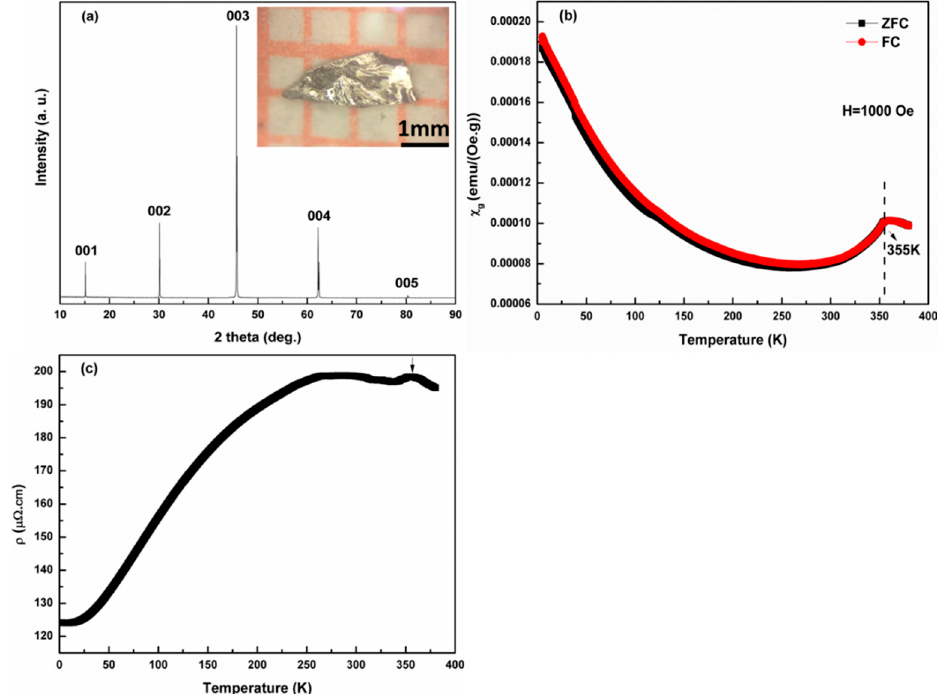
Figure 1. ( a ) X-ray diffraction (XRD) pattern of Fe 2 As single crystal. The inset shows the photograph of Fe 2 As single crystal; ( b ) Zero-field cooled (ZFC) and field cooled (FC) susceptibilities versus temperature for Fe 2 As single crystal with applied magnetic field parallel to ab-plane, an obvious antiferromagnetic transition can be seen at about 355 K; ( c ) Temperature dependence of ab plane resistance at ambient pressure. An obvious anomaly at about 355 K in the resistivity curve was marked by arrow.